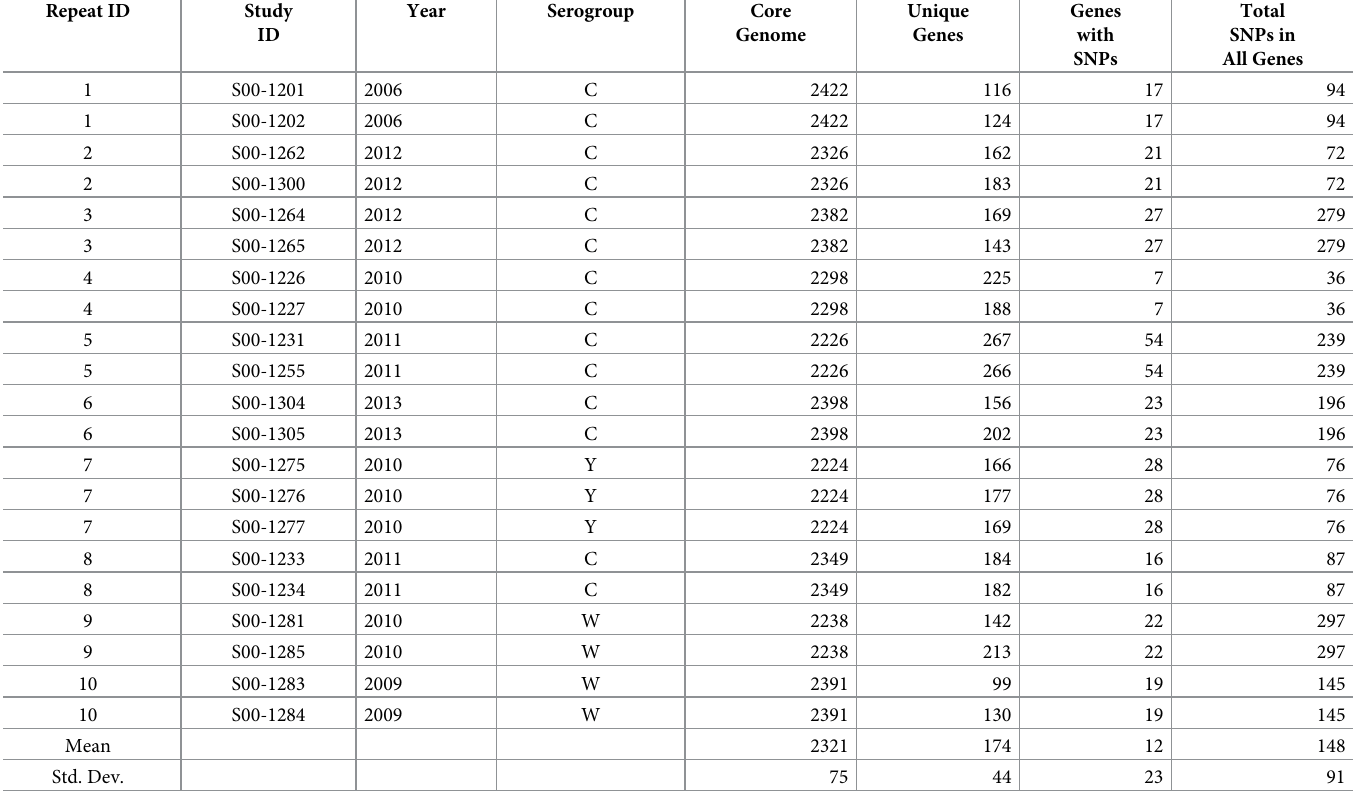
Table 2. Comparative genomics of isolates from the same